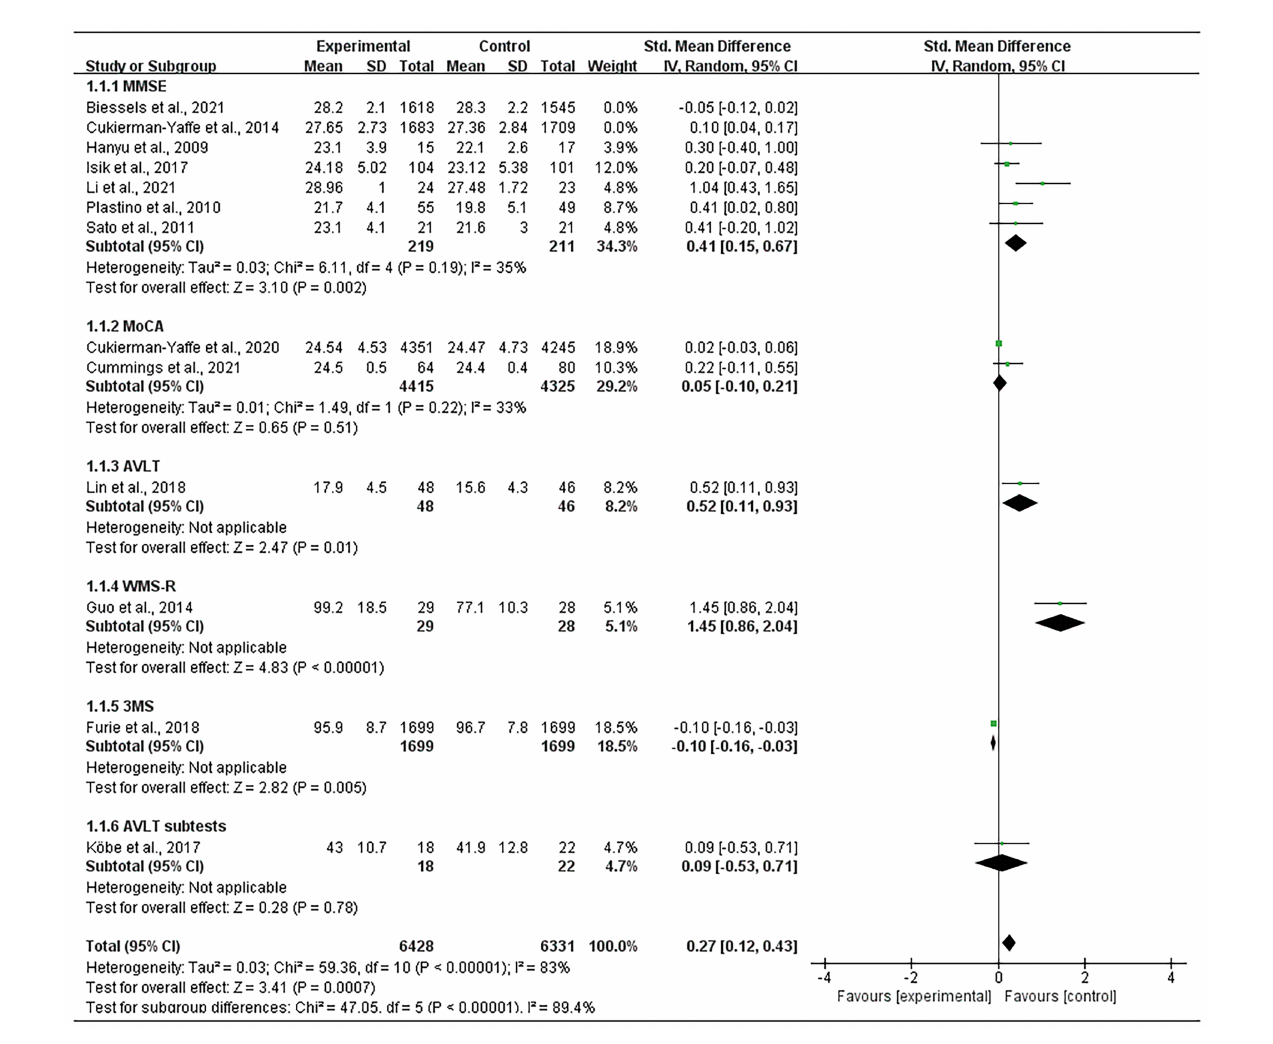
FIGURE 5 Forest plot of adjusted standard mean difference in cognitive assessment scores.